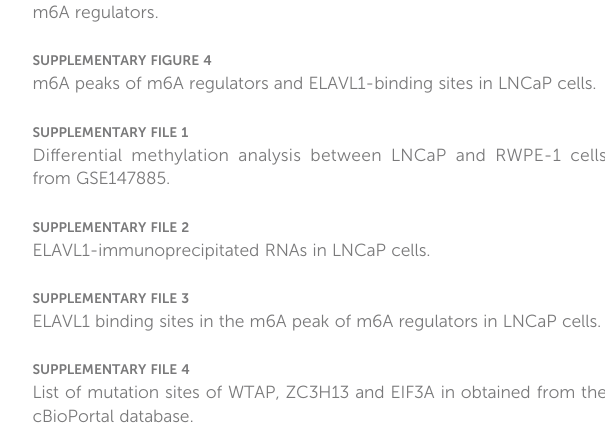
SUPPLEMENTARY FIGURE 1 Correlationbetweentheexpressionlevelandcopynumberofm6Aregulators. SUPPLEMENTARY FIGURE 2 Comparison of m6A regulator expression between mutation and no mutation. *p<0.05, ***p<0.001. SUPPLEMENTARY FIGURE 3 Correlation between ELAVL1 expression and the expression of other m6A regulators. SUPPLEMENTARY FIGURE 4 m6A peaks of m6A regulators and ELAVL1-binding sites in LNCaP cells. SUPPLEMENTARY FILE 1 Differential methylation analysis between LNCaP and RWPE-1 cells from GSE147885. SUPPLEMENTARY FILE 2 ELAVL1-immunoprecipitated RNAs in LNCaP cells. SUPPLEMENTARY FILE 3 ELAVL1 binding sites in the m6A peak of m6A regulators in LNCaP cells. SUPPLEMENTARY FILE 4 List of mutation sites of WTAP, ZC3H13 and EIF3A in obtained from the cBioPortal